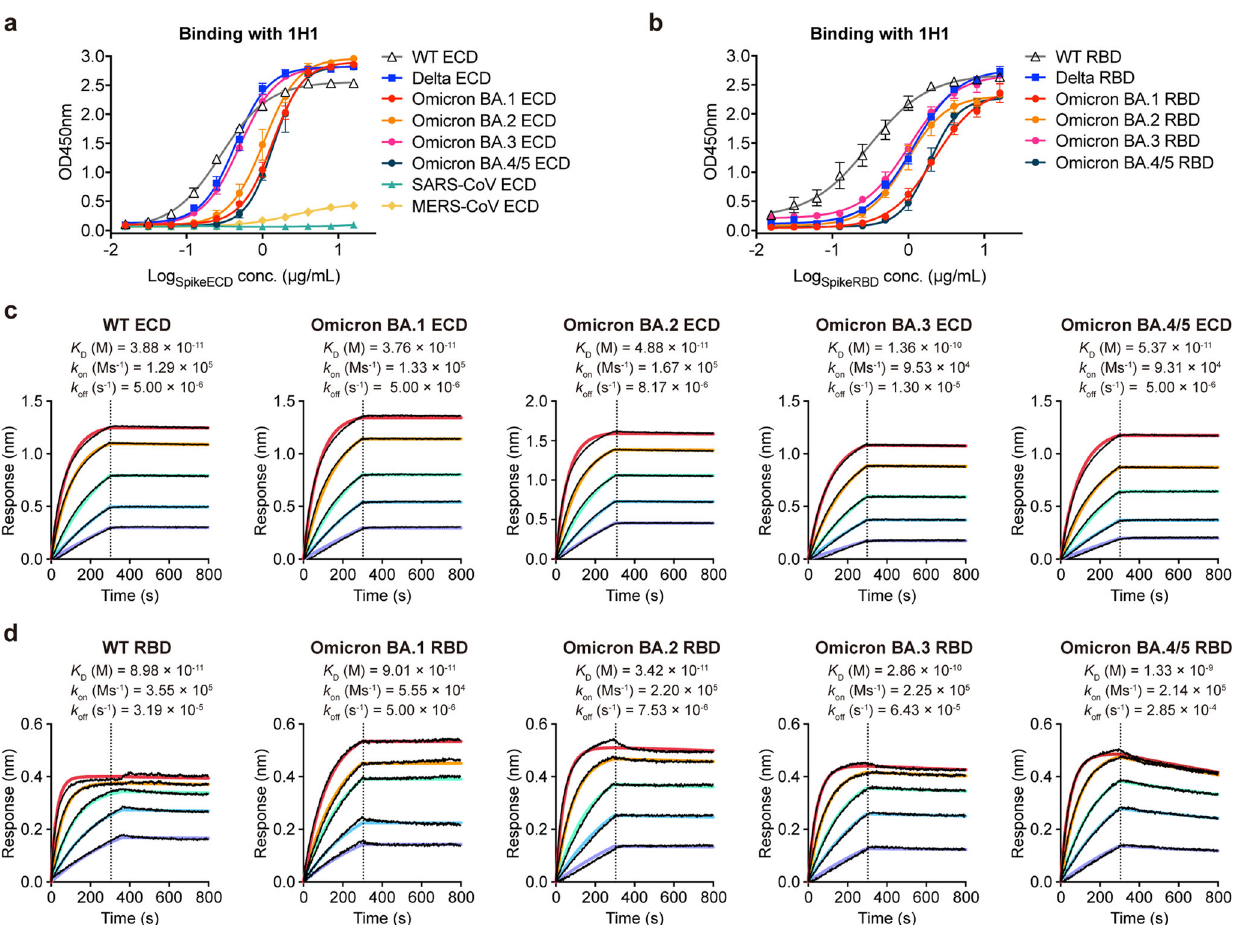
Fig. 2 Broad binding af fi nity of 1H1. a , b binding of 1H1 to different spikes ( a ) or RBDs ( b ) of SARS-CoV-2 variants as measured by ELISA. Data are shown as the mean values of three replicates. Error bars indicate standard deviation (SD) of at least three biological replicates. c binding kinetics of 1H1 to different spike ECD proteins of SARS-CoV-2 variants as measured by BLI. d binding kinetics of 1H1 to different spike RBD proteins of SARS-CoV-2 variants as measured by BLI. Black lines were the original curves, while colored lines were the fi tted curves. K D apparent values are shown for 1H1 IgG binding to spike ECD and RBD proteins using a 1:1 global fi t